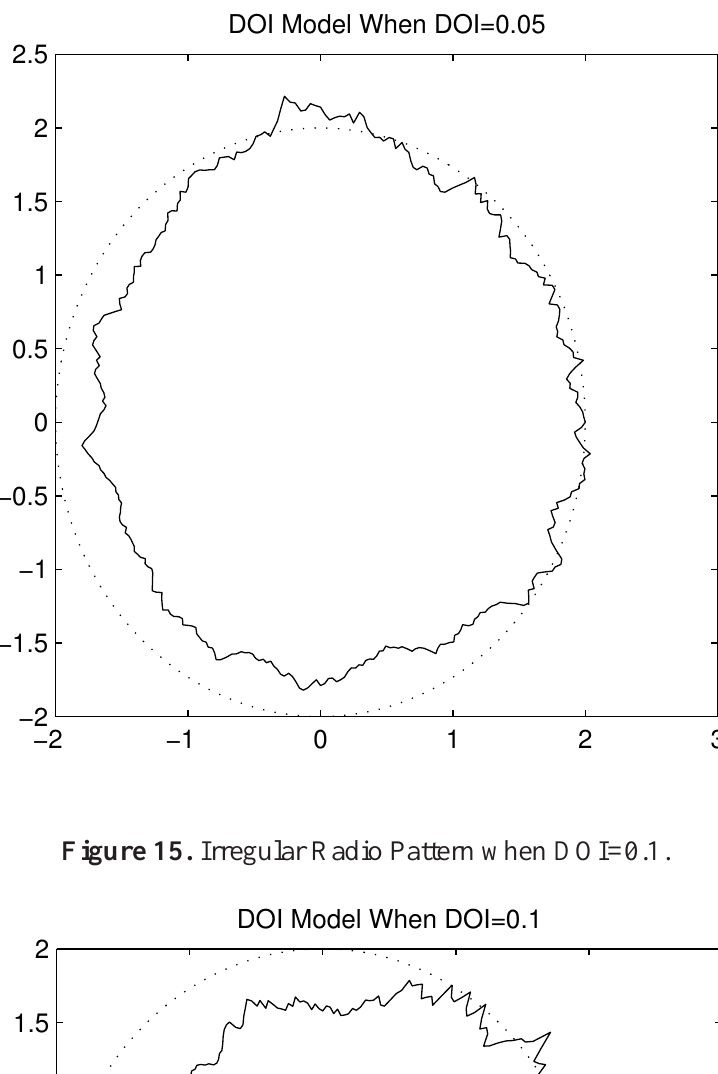
Figure 14. Irregular Radio Pattern when DOI=0.05.